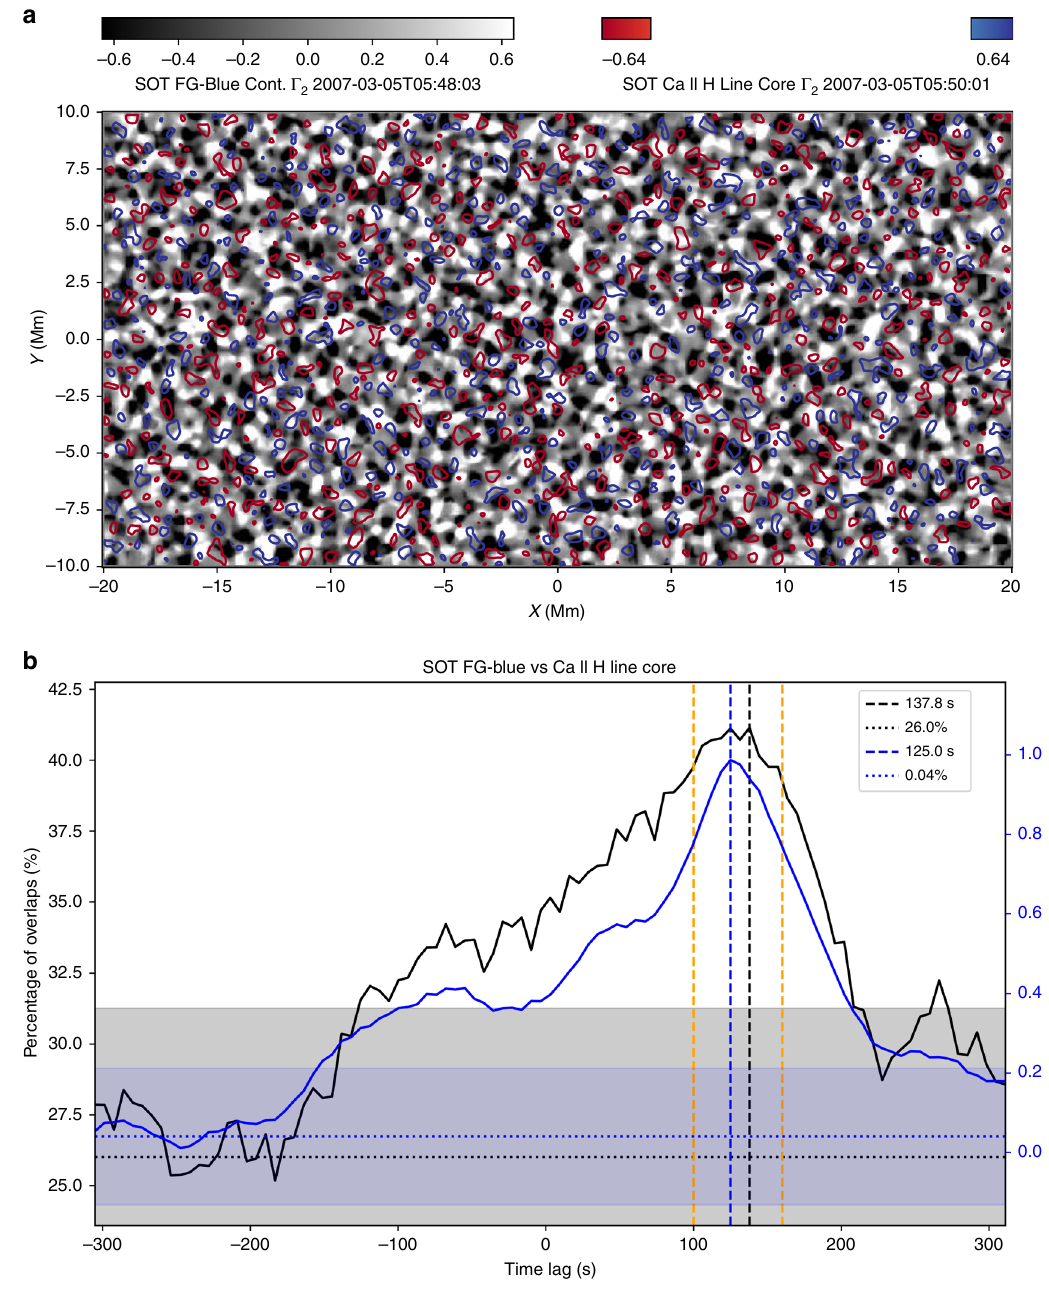
Fig. 3 Correlations between photospheric and chromospheric swirls detected by the SOT. The black-white background in a shows the Γ 2 distribution of the photospheric observation by the SOT FG-Blue continuum at 05:48:03 UT. It has a peak correlation index (CI ~ 2.4%) with the Γ 2 distribution of the Ca II H chromospheric observation (red and blue contours) 118 seconds later at 05:50:01. The two unitless colorbars show the scales of Γ 2 . b The blue and black solid curves are the CI and percentage of overlaps between the SOT photospheric and chromospheric swirls varying with different time lags, respectively. The vertical blue and black dashed lines represent the peak of the CI and percentage of overlaps at a time lag of 125 and 138 s, respectively. The two vertical orange dashed lines correspond to time lags of 100 and 160 s, respectively. Via performing 50 times of random shuf fl e on the series of observations, we have also obtained their corresponding levels of errors (blue and black dotted lines, 0.04% and 26%) and 5 σ ranges (blue and grey shadows). Source data are provided in the Source Data fi fl ux tube. Figure 4a depicts a snapshot of the simulation (see magnetic fi eld perturbations at the bottom (see Supplementary Supplementary Movie 1) at t ≈ 93 s. The perturbation of the Movie 2) are suggested to be the trapped initial perturbations due rotational motion has now already travelled up to 600 km above to the very low (~0.5 km s − 1 ) local Alfvén speed outside the fl ux tube (see Supplementary Fig. 6). the bottom. It is clear from the Supplementary Movie 2 (as well as In order to further analyse these pulses, a vertical slit was Fig. 4), that, the azimuthal magnetic fi eld perturbation is opposite placed close to the centre of the fl ux tube. Corresponding time- oriented to the velocity fi eld perturbation, indicating strongly the distance plots are shown in Fig. 4b – d. Panel b of the vertical Alfvén nature of the pulse. The remnant weak velocity and